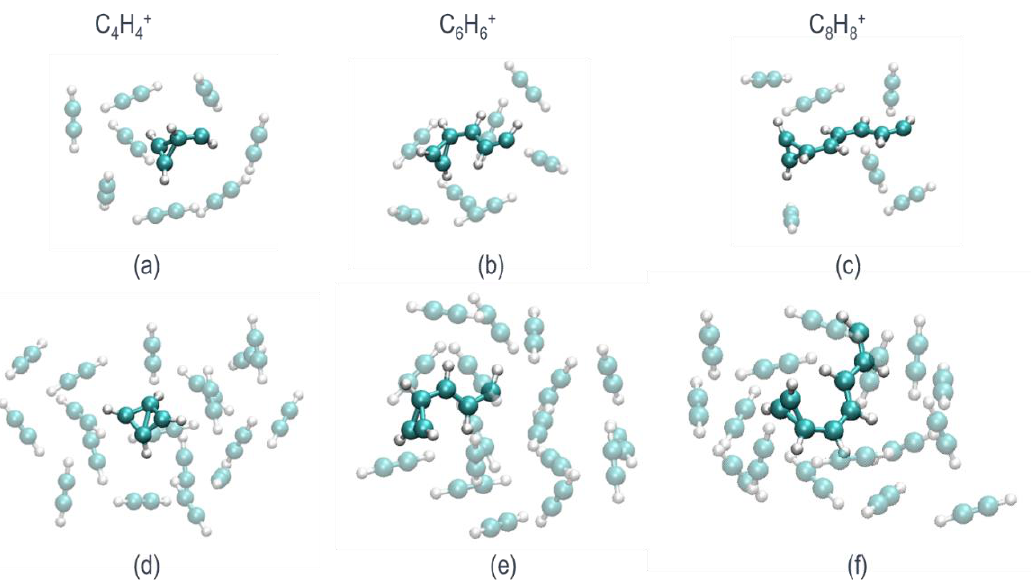
Figure 2. ( a – c ) are decamer clusters optimized on the cationic PES with C 4 H 4+ , C 6 H 6+ , and C 8 H 8+ core-bonded structures, respectively; ( d – f ) correspond to the eicosamer clusters that also show C 4 H 4+ , C 6 H 6+ , and C 8 H 8+ core-bonded structures.